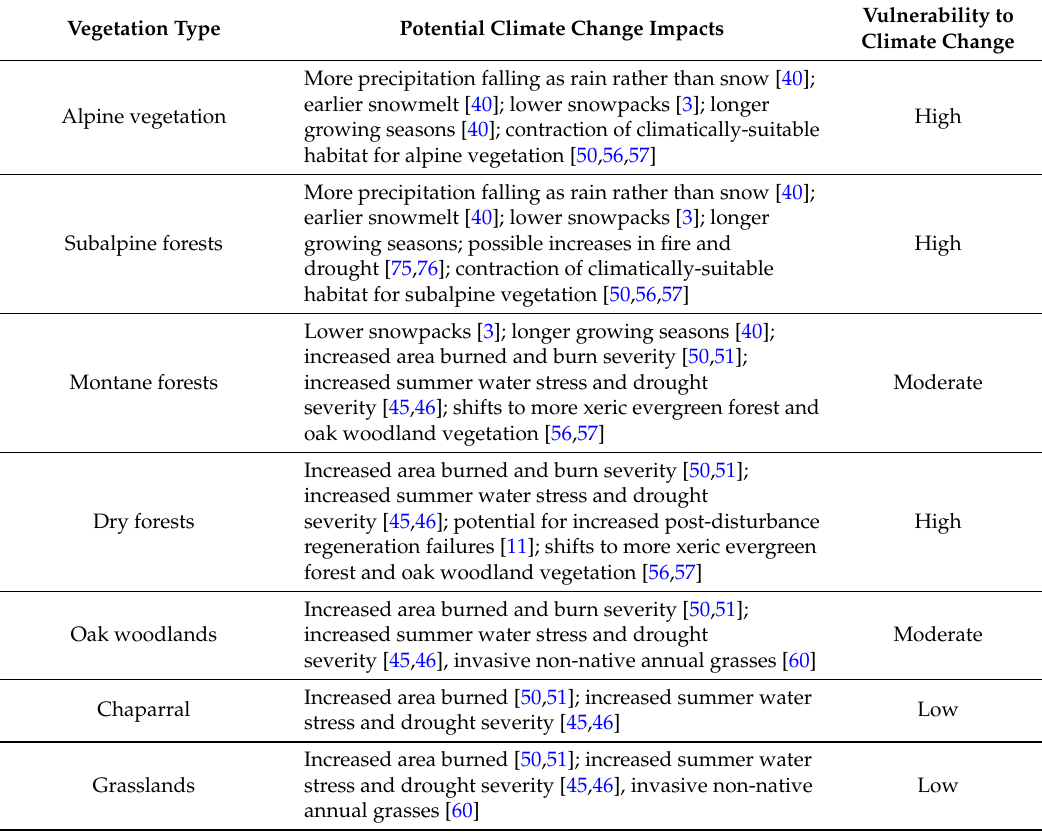
Table 1. Summary of vulnerability of vegetation types in the Rogue Basin in southwestern Oregon, as determined by the climate change vulnerability assessment described above. Vegetation types with high vulnerability to climate change are likely to contract significantly or may experience extensive mortality in the future, whereas vegetation types with low vulnerability to climate change are likely to maintain current area or increase in area (although their distribution across the landscape may shift). Composition of all vegetation types is likely to shift to more drought and fire tolerant